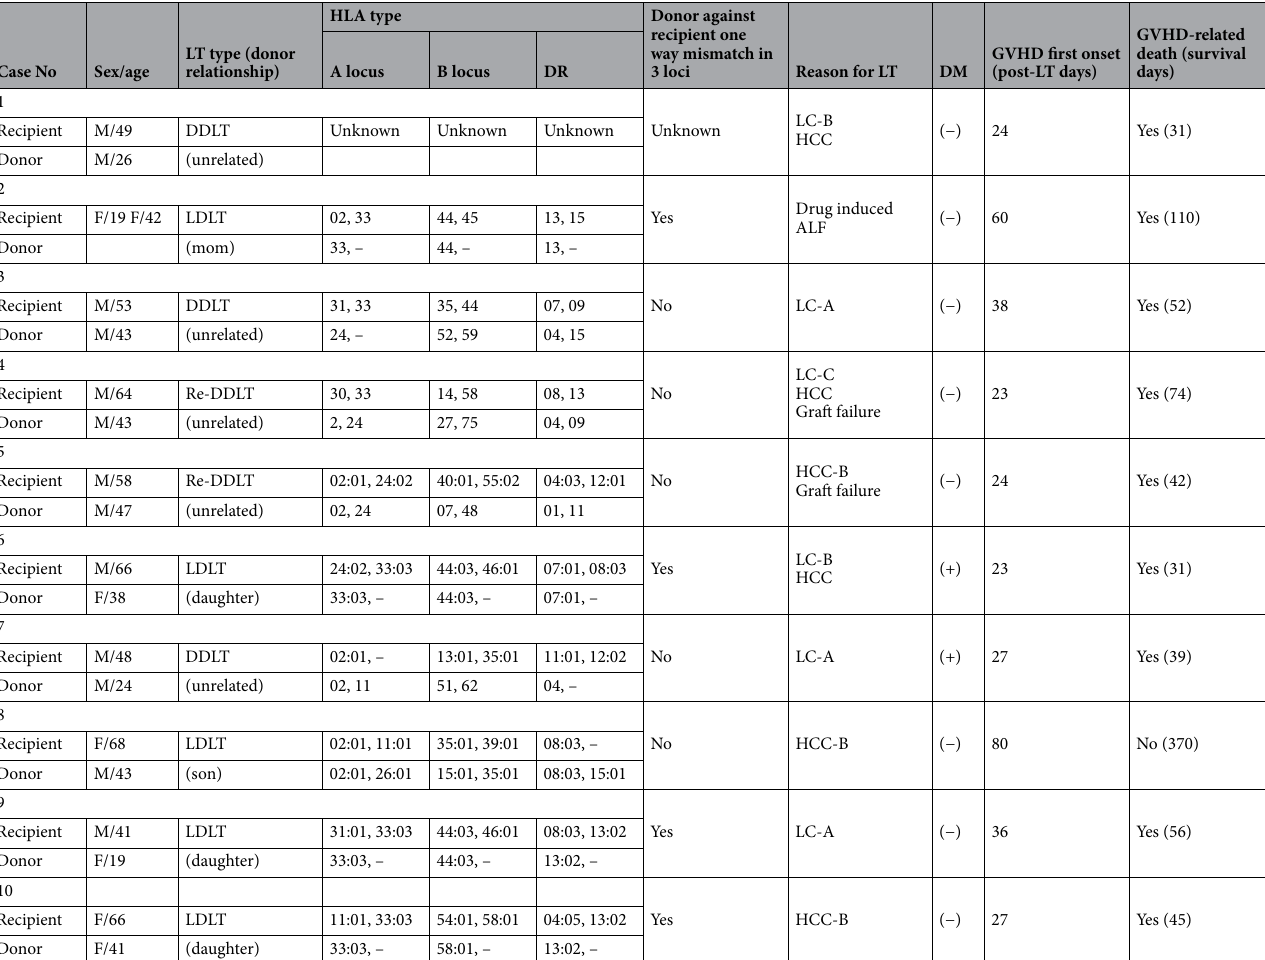
Table 5. Characteristics and HLA types of each patient with